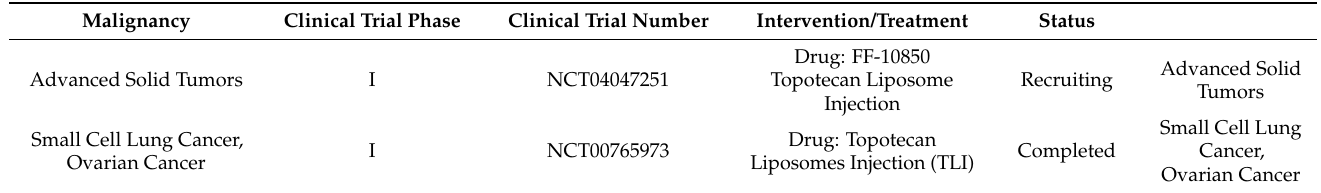
Table 2. List of clinical studies employing targeted topotecan